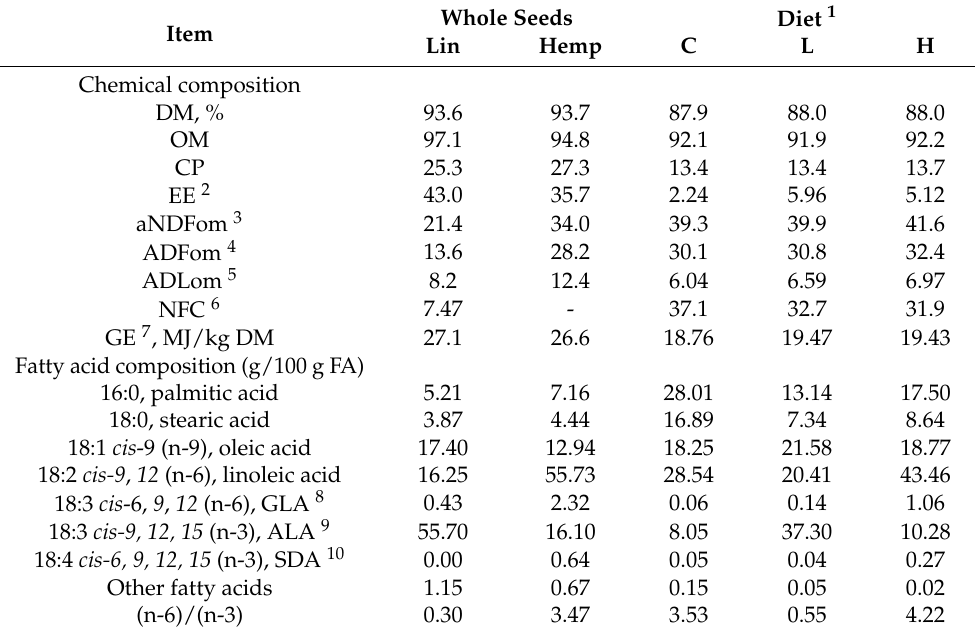
Table 2. Chemical analysis (% of DM, unless otherwise stated) of linseeds, hemp seeds, and the three experimental